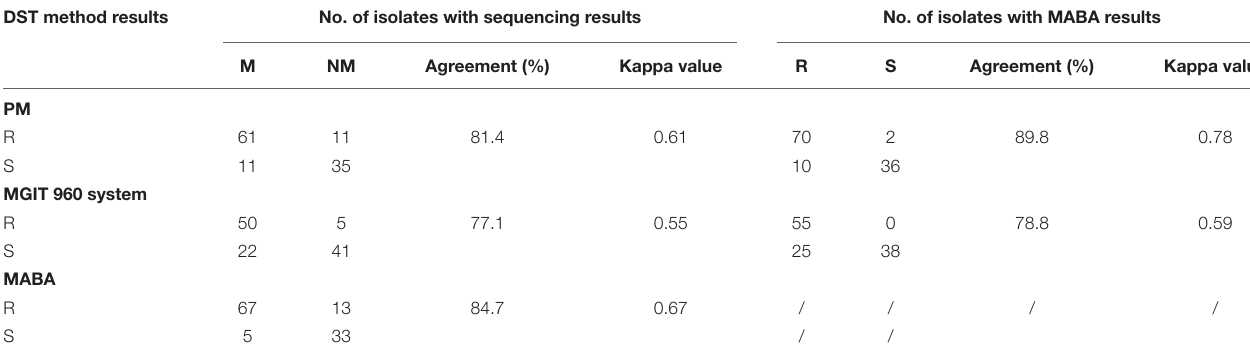
TABLE 1 | Agreement between phenotype DST and DNA sequencing.